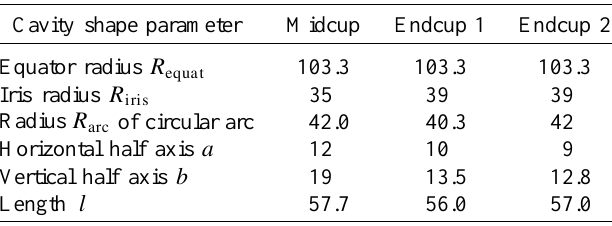
TABLE III. Half-cell shape parameters (all dimensions in